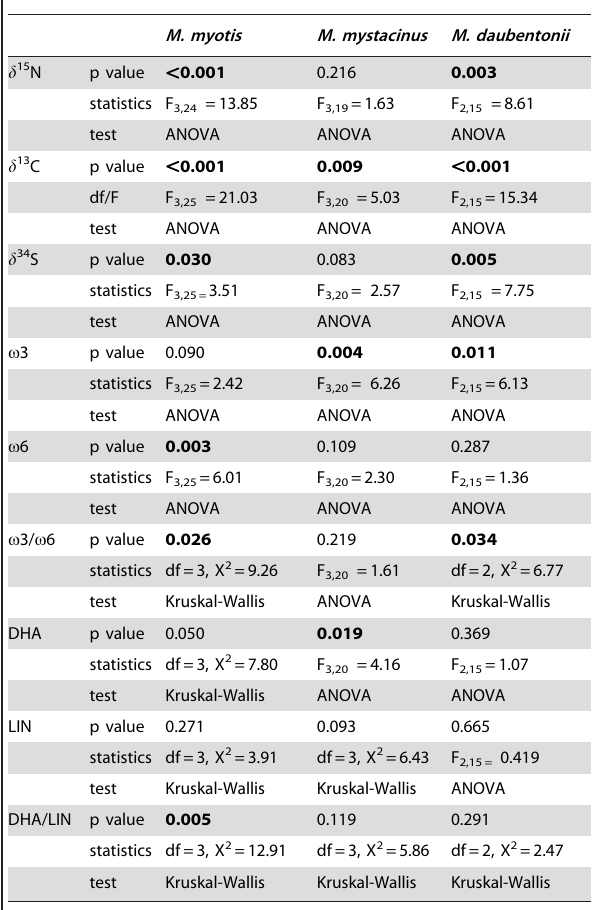
Table 2. Results of the ANOVAs and Kruskal-Wallis tests for the comparison of the stable isotope and fatty acid values between the different sampling dates for each